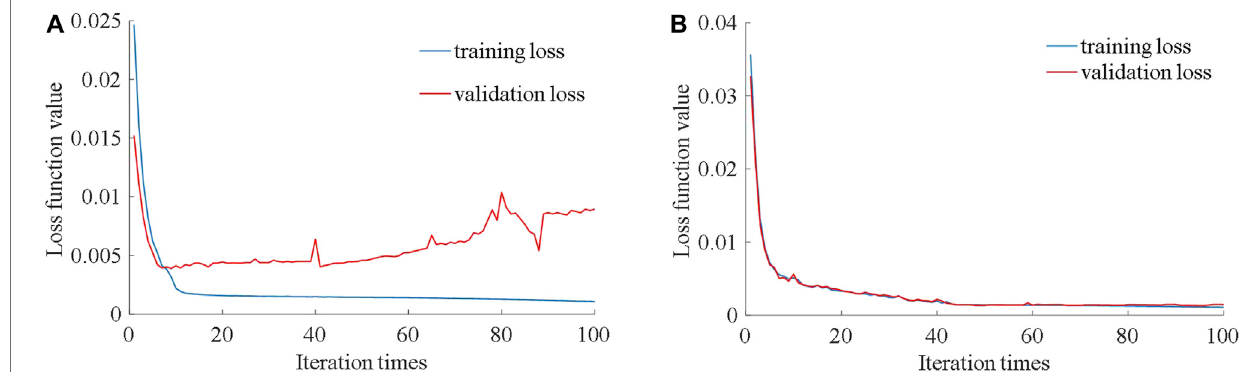
FIGURE 6 | The curve of the loss function during the training of the model.